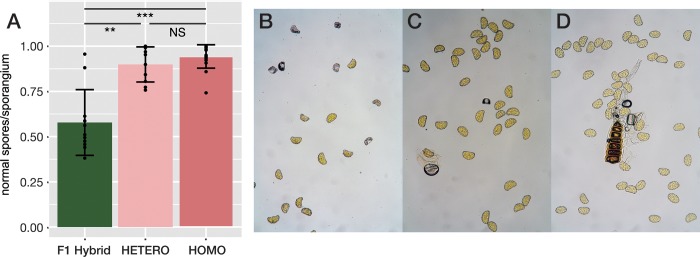
The level of fertility among three categories, F1 hybrids, heterozygous individuals within each type and homozygous individuals within each type.The proportion of normal spores in F1 hybrids between types (F1 hybrid in the figure, left), heterozygous individuals within each type (HETERO in the figure, centre), and homozygous individuals within each type (HOMO in the figure, right) (A), and photographs of spore morphologies in each category: (B) an F1 hybrid (sample ID 26–4) between types, (C) an heterozygous individual (sample ID 15–2) of the East-type, and (D) an homozygous individual (sample ID 15–1) of the East-type. In the graph (A), each point in the bar indicates an individual data point; error bars represent SE (±). Asterisks represent differences at confidence levels of ** p < 0.005 and *** p < 0.001.